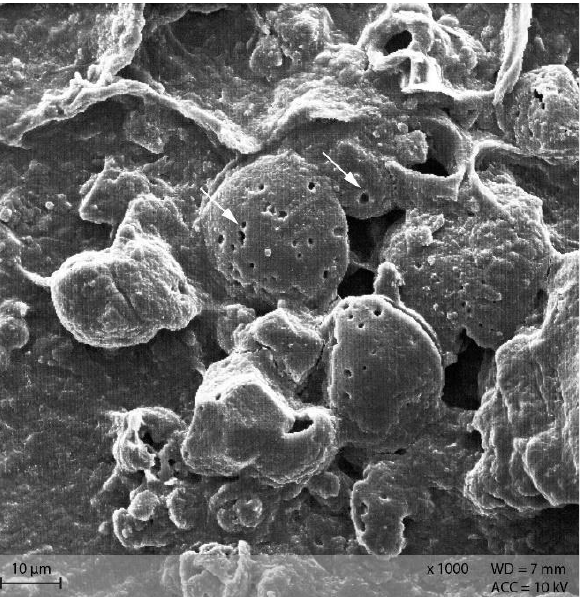
Figure 11. Starch granules with small pinholes , indicating the beginning of enzymatic degradation in the small intestine. Example from diet PEL (Scanning electron microscopy; ↓ indicating pinholes).